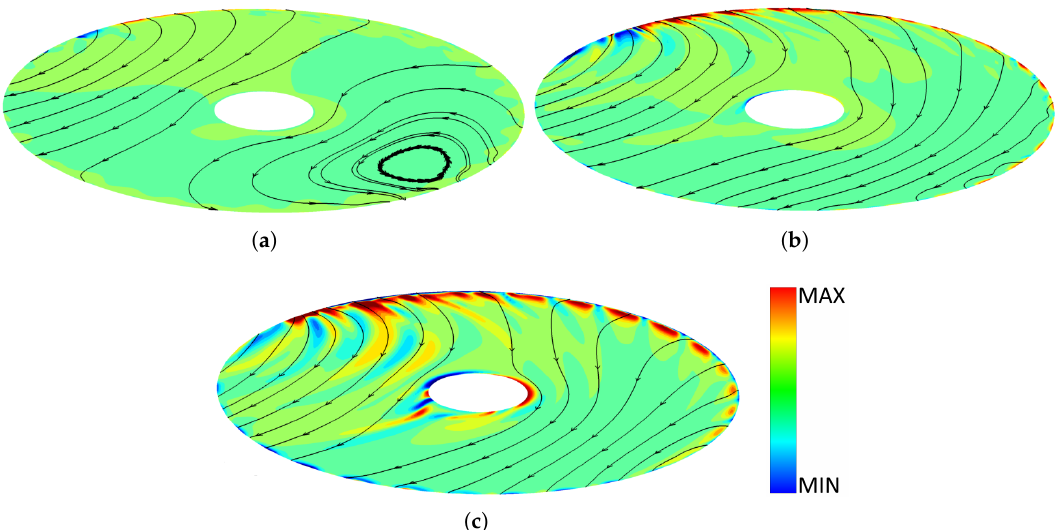
Figure 5. Contour of velocity on z-direction for various axial gap: ( a ) h/H = 0.00886; ( b ) h/H = 0.0177; and ( c ) h/H =